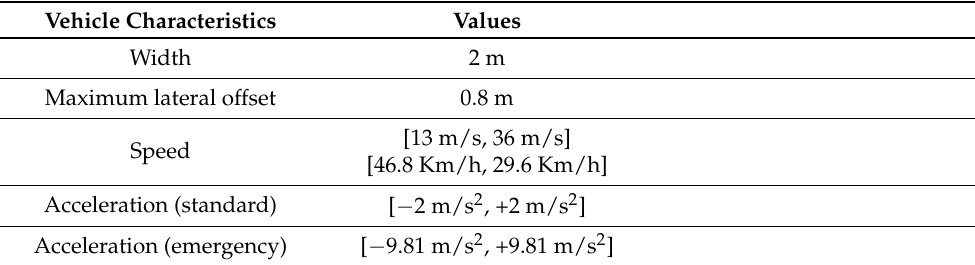
Table 1. Vehicle characteristics and driving conditions in the set of experiments described in the following